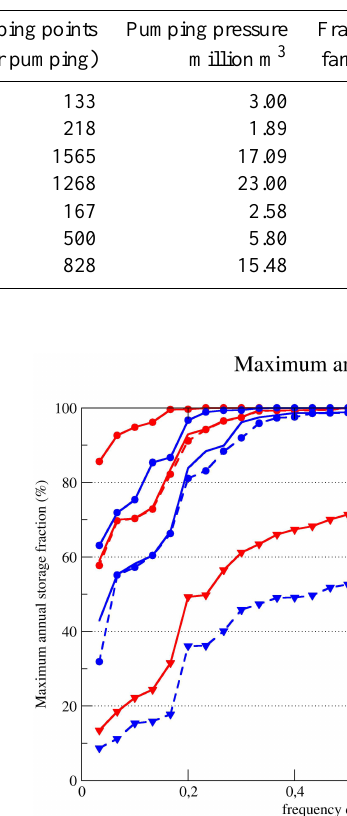
Table 1. Estimation of the fraction of small farm dams based on known pumping pressure derived from surface water pumping in seven river basins of the Pays de la Loire region. The pumping pressure was provided by the Loire-Bretagne water agency in 2000. A uniform water depth of 3 m is assumed for small farm dams.